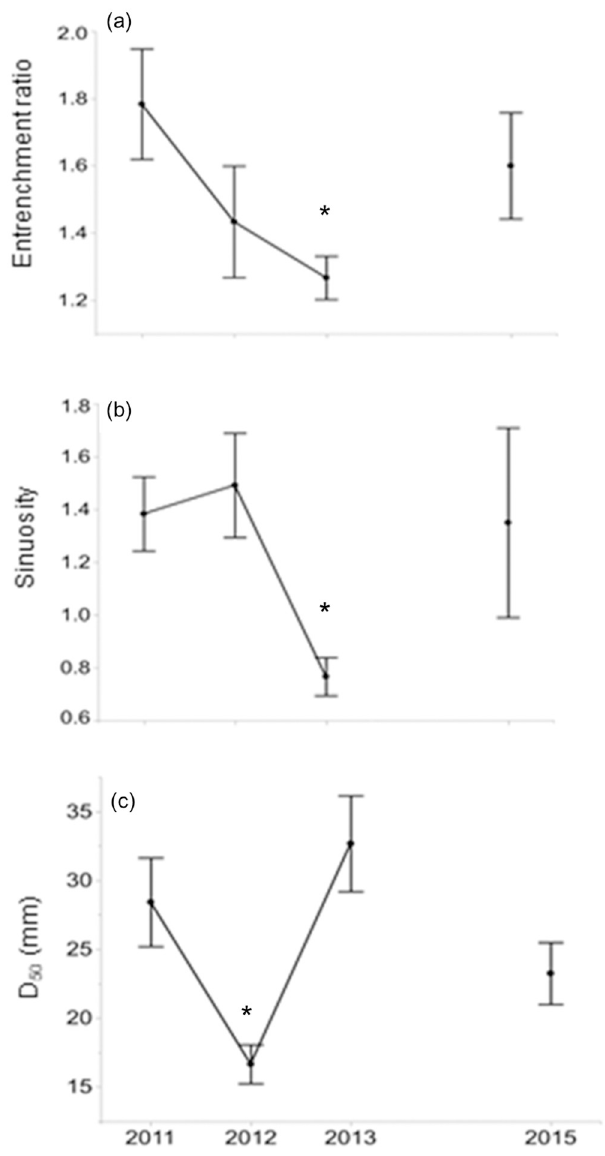
Fig 3. Line graphs of hydrogeomorphic predictors by year. Average values +/- 1 SE for three hydrogeomorphic variables showing significant differences between years examined at the 12 study sites from 2011–2013, and in 2015 (four sites only): (a) entrenchment ratio, (b) sinuosity, and (c) D 50 (mm). Asterisk indicates year that was significantly